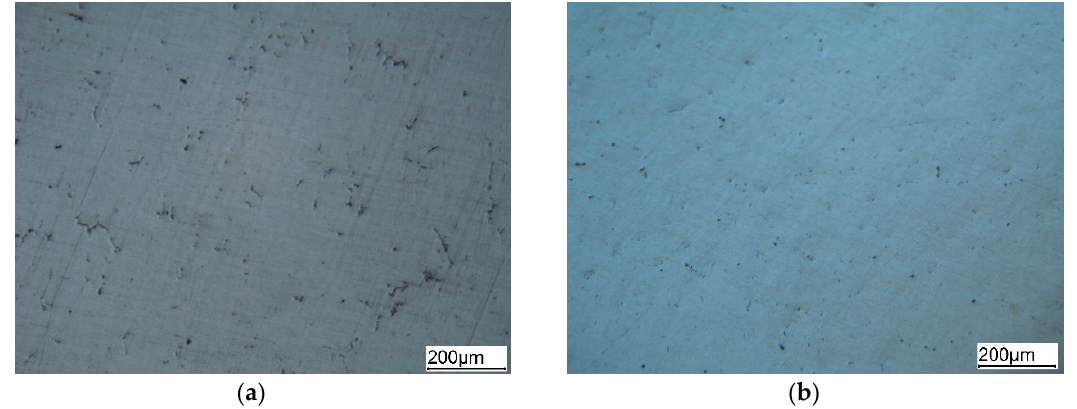
Figure 9. Optical micrographs showing a different content of intermetallic compound (IMC) (Al–Cu–Mg–Zn) particles in the matrix of ( a ) the HC sample and ( b ) the SO sample.